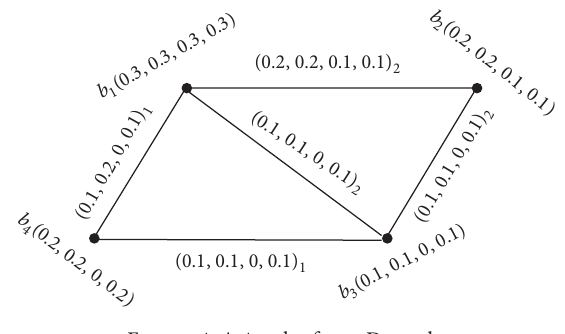
Figure 4: A 4-polar fuzzy 𝐷 2